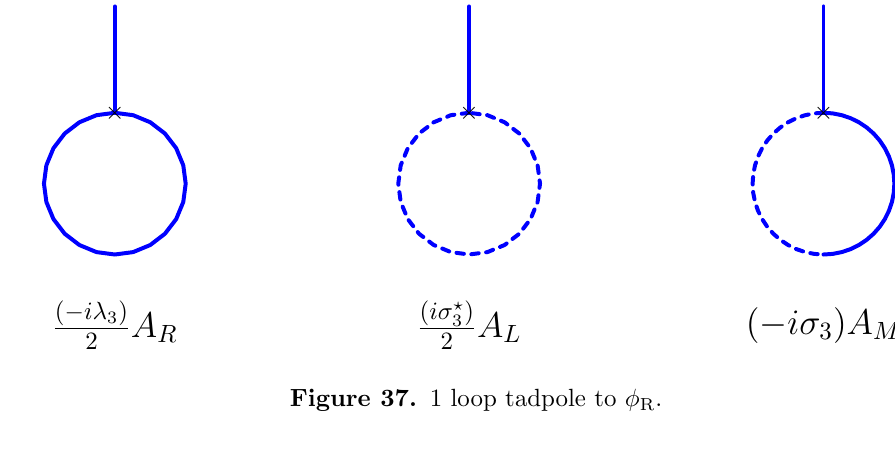
Figure 37. 1 loop tadpole to (cid:30) R